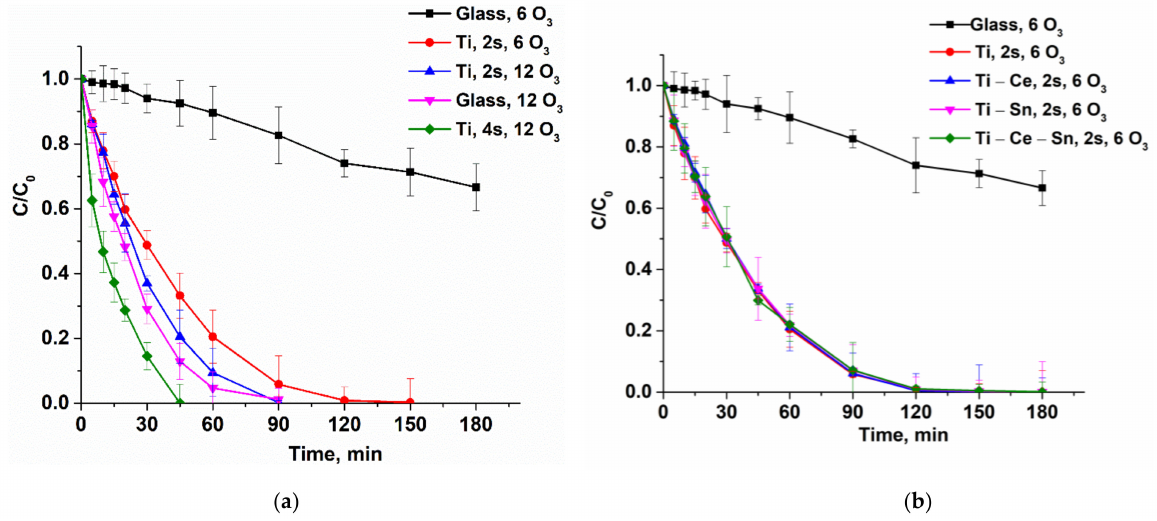
Figure 6. ( a ) Evolution of paracetamol normalized concentration during the oxidation process for (Ti) system at different ozone concentrations and number of slides; ( b ) Comparison of prepared catalytic systems at a lower ozone input and two slides.